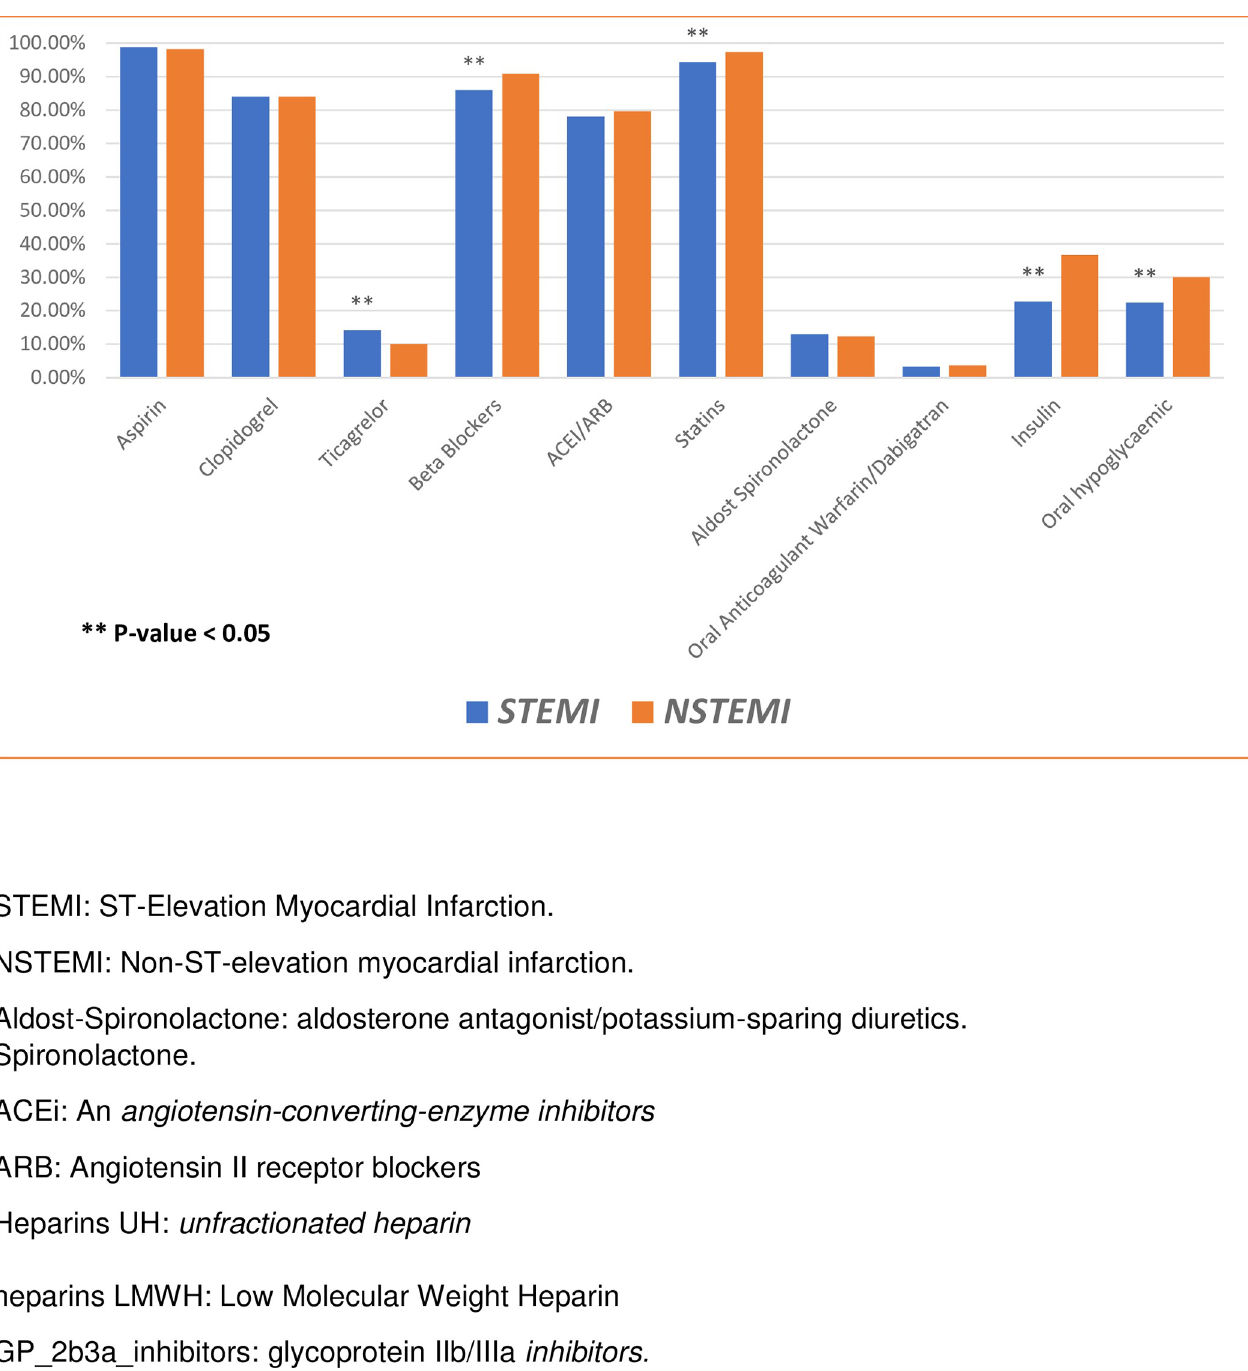
Fig 3. Medications use at hospital discharge for patients with acute myocardial infarctions. STEMI: ST-elevation myocardial infarction; NSTEMI: non-ST- elevation myocardial infarction.